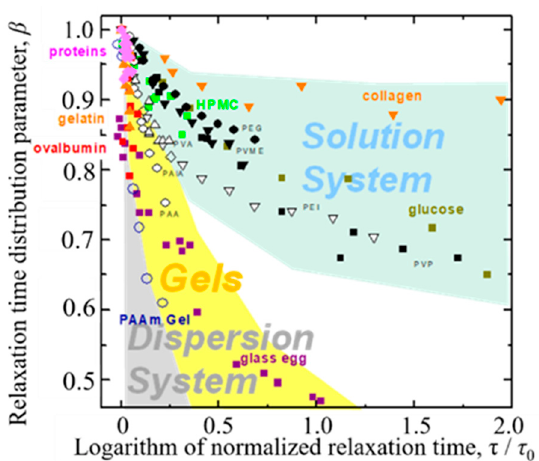
Figure 6. The τ – β diagram offers fractal dimension, 1 ≤ d G ≤ 2 for solution systems and 0 ≤ d G ≤ 1 for dispersion systems. Sample names are indicated in the figure with usual abbreviations.